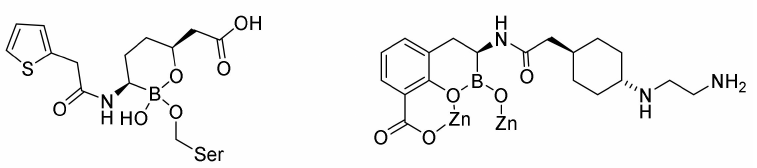
Figure 25. Serine- β -lactamase-varbobactam complex [129] and metallo- β -lactamase-taniborbactam complex